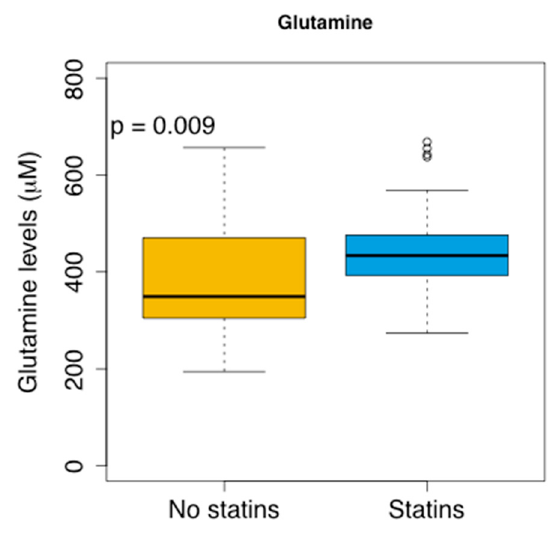
Figure 6. Glutamine levels according to the administration of the statins. t -test ( p -value).